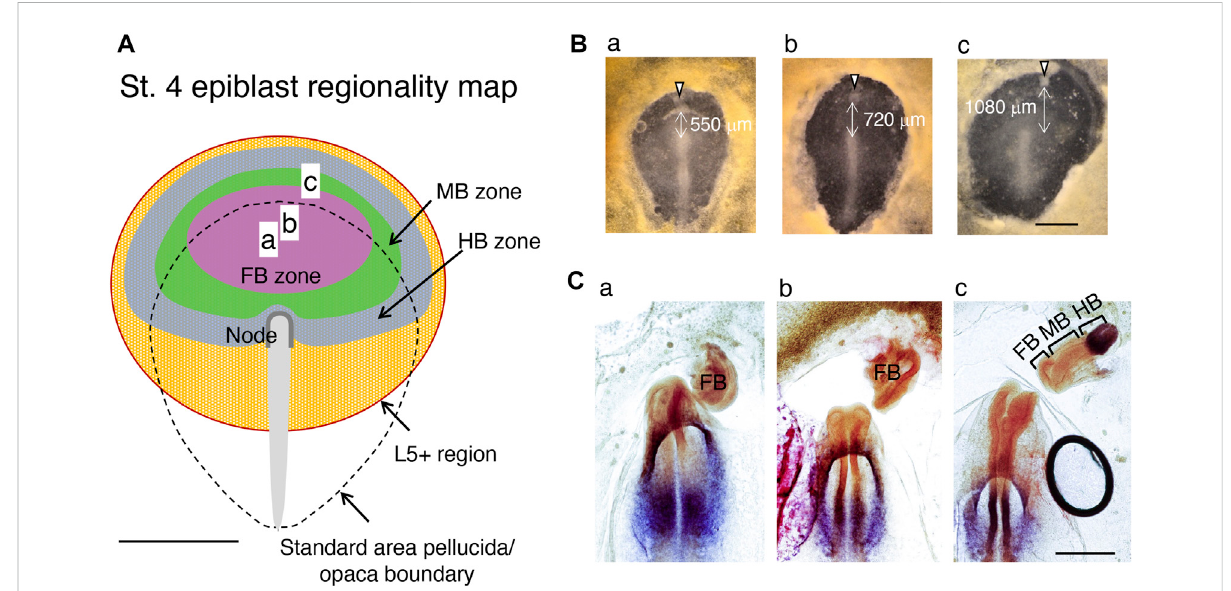
FIGURE 7 Regionality map of the st. 4 epiblasts constructed using available data. (A) Distribution of the head tissue developmental potential of anterior epiblast cells at st. 4. The developmental potential extends by crossing the area pellucida boundary to the L5+ domainof the area opaca (Streit et al., 1997). The zones with developmental potential for the individual brain portion are drawn using pale colors. (a – c) The AME graft positions in (B) . (B) Embryos with AME grafts close to the area pellucida anterior limit (arrowheads) with variable distances from the node. (C) The secondary brain tissues inembryosin (B) after18 h,hybridizedfor Otx2 and Gbx2 expression andassessedforthebrainportions. Scalebars,1 mmin (A,B) ,500 µmin (C) . Adapted from Figure 7 of Yoshihi et al.